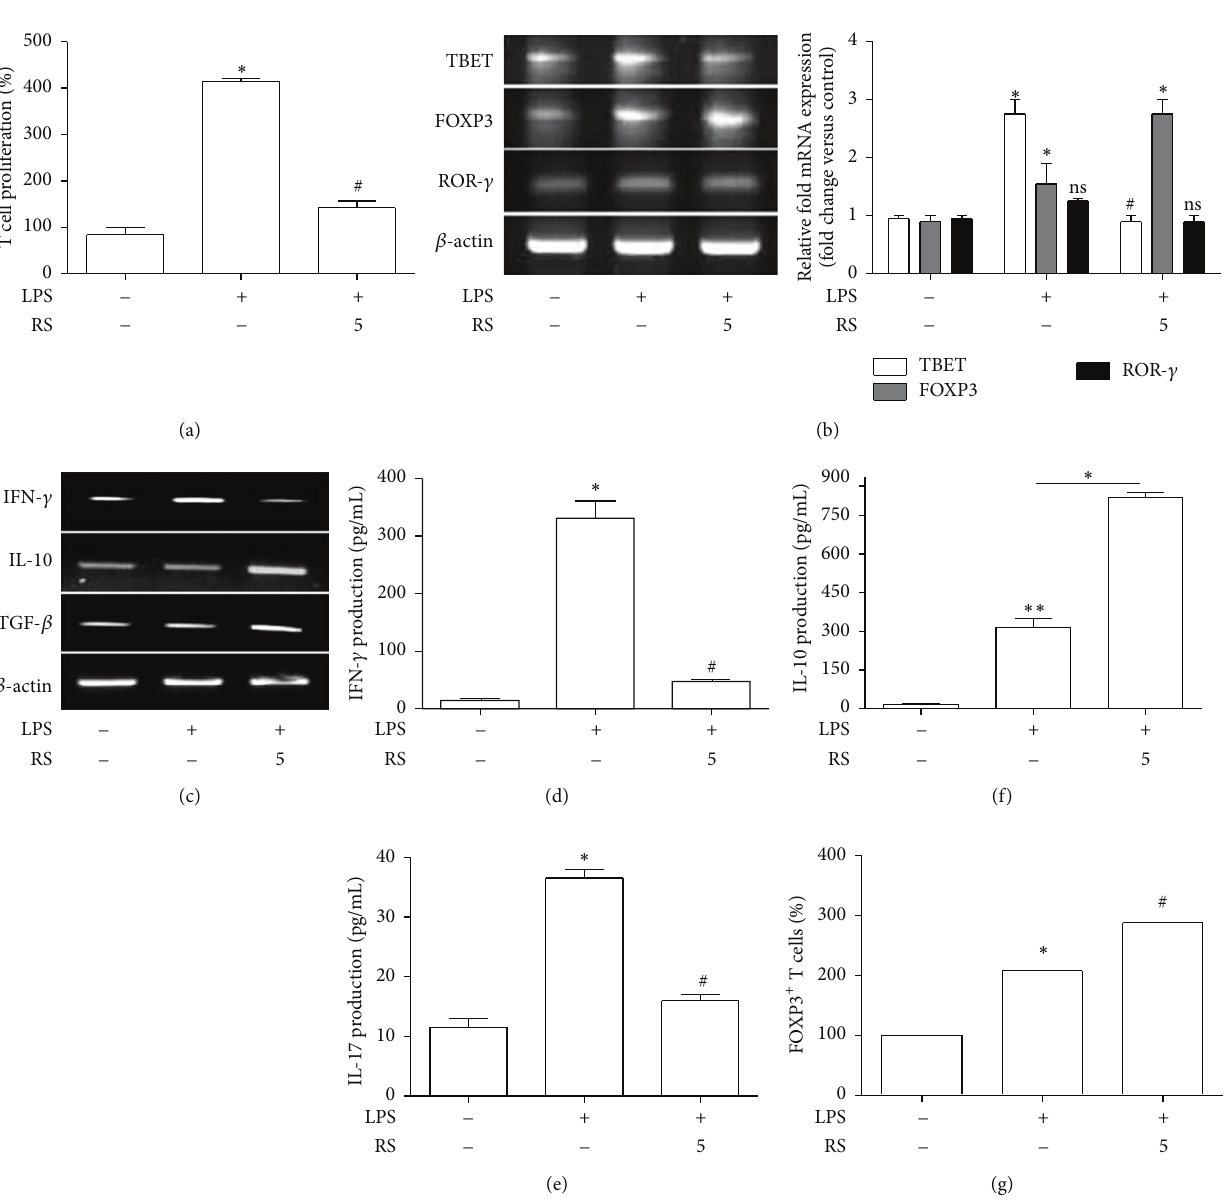
Figure 6: LPS-Rs skews T cell response with induction of Tregs cells. Splenocytes were treated with or without LPS-Rs followed by LPS treatment and cell proliferation was assayed by MTT assay after 72 hrs (a). T helper associated transcription factors: TBET, FOXP3, and ROR- 𝛾 (b) and cytokines IFN- 𝛾 , IL-10, and TGF- 𝛽 (c) were assayed by RT-PCR after 48 hrs. The secretary IFN- 𝛾 , IL-17, and IL-10 from culture supernatant were analysed by ELISA after 72 hrs (d, e, and f). The differentially treated splenocytes after 72hrs were fixed, surface stained with FITC-CD4 mAb and APC-CD25 mAb followed by permeabilization and intracellular staining with PE-Foxp3 mAb, and analyzed by flow cytometry. The CD4 + CD25 + cells were gated and Foxp3 expression was determined and expressed as percentage change (g). The error bars represent the mean ± SEM from three independent experiments ( ∗ 𝑝 ≤ 0.05 versus control and # 𝑝 ≤ 0.05 versus LPS). UN: untreated; LPS: lipopolysaccharide from Escherichia coli 055 : B5 (1 𝜇 g/mL); RS: lipopolysaccharide from Rhodobacter sphaeroides (0.5–5 𝜇